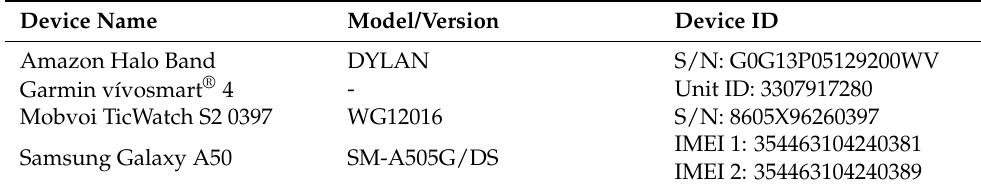
Table 2. Full list of devices used in this